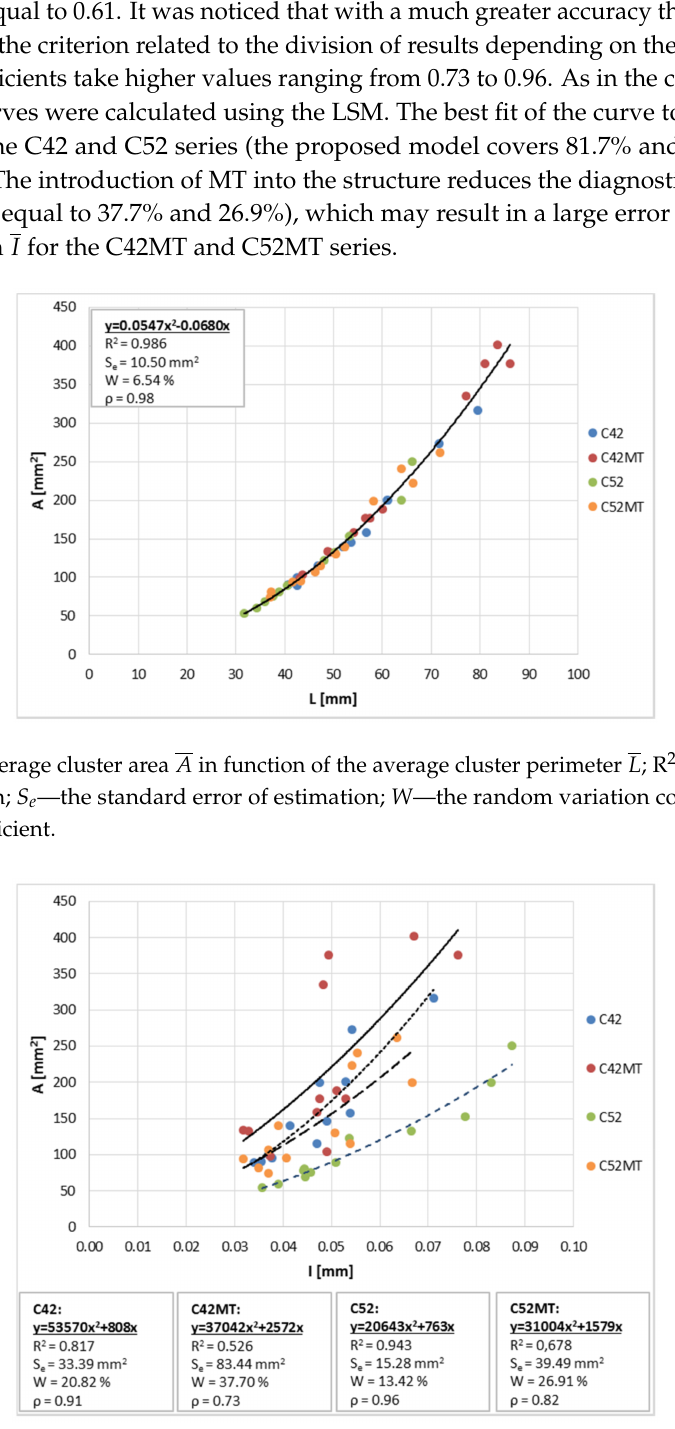
Figure 8. The average cluster area A in function of the crack average width I